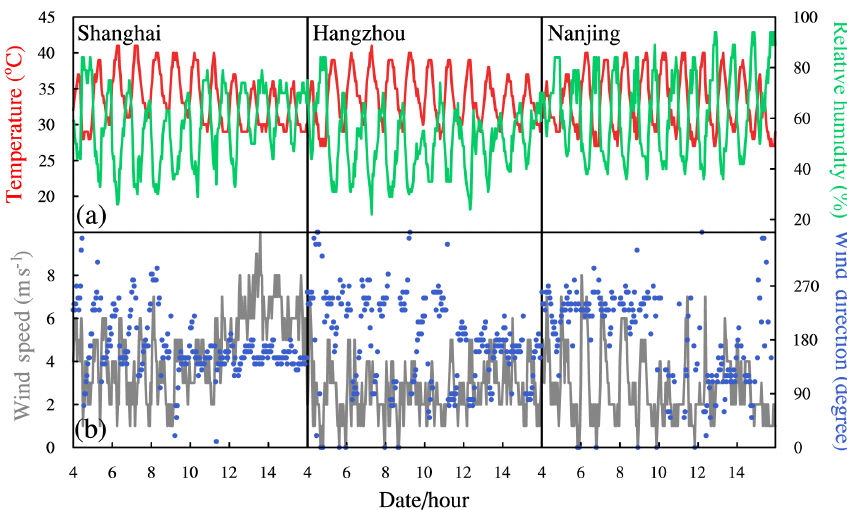
Figure 4. Temporal variations of the main meteorological parameters at Shanghai, Hangzhou and Nanjing meteorological stations during 4–15 August 2013, including (a) 2m air temperature (the red solid line) and 2m relative humidity (the green solid line) and (b) 10m wind speed (the gray solid line) and 10m wind direction (the blue scatter points).